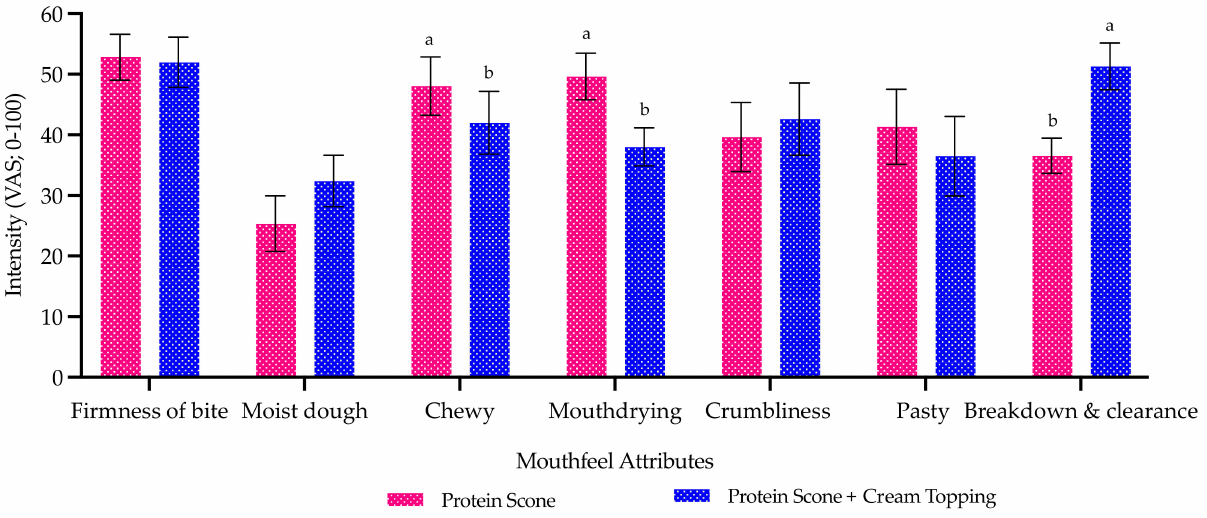
Figure 3. Mean mouthfeel attribute ratings of scones with and without cream topping. Data represents means of two replicates ± standard error from trained sensory panel ( n = 8) measured on visual analogue scales (VAS; 0–100). Differing small letters represent sample significance from multiple comparisons. All attributes are fully defined in Table